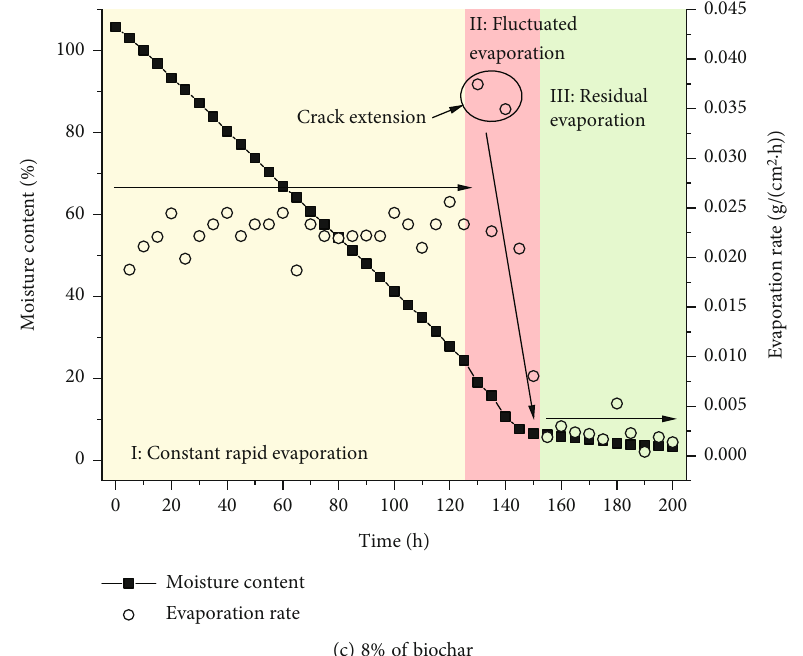
Figure 1: Variation of moisture content and evaporation rate of soil samples with di ff erent contents of corn stalk biochar.